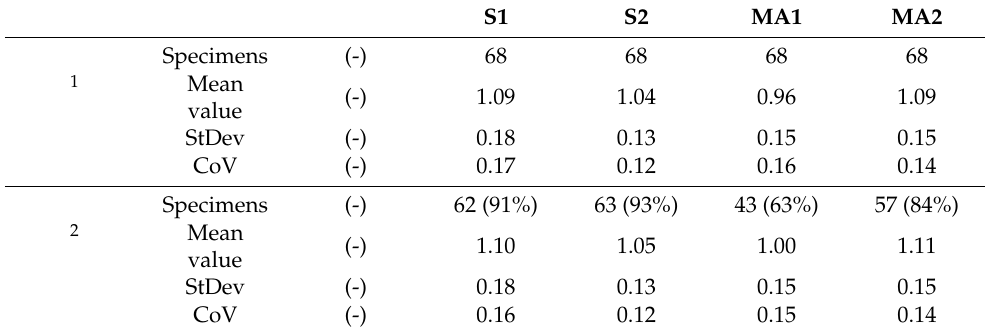
Table 8. Statistics of experimental vs. theoretical results for all specimens in the database.